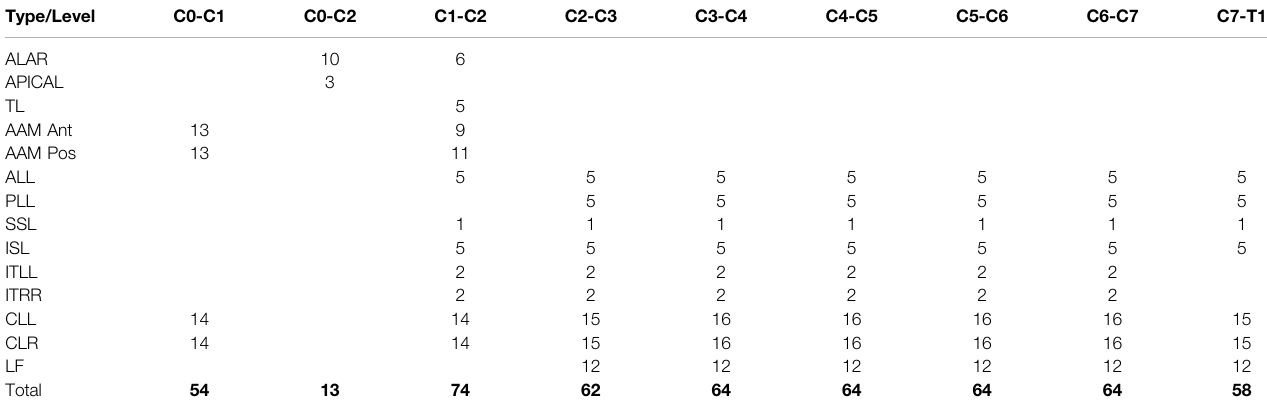
The apical, alar, TL; transverse ligament, AAOM; anterior atlantooccipital membrane, POAM; posterior atlantooccipital membrane, ALL; anterior longitudinal ligament, PLL; posterior longitudinal ligament, SLL; supraspinous ligament, ISL; interspinous ligament, ITLL; intertransverse ligament left, ITRR; intertransverse ligament right, CLL; capsular ligament left, CLR; capsular ligament right and LF; ligament fl avum.